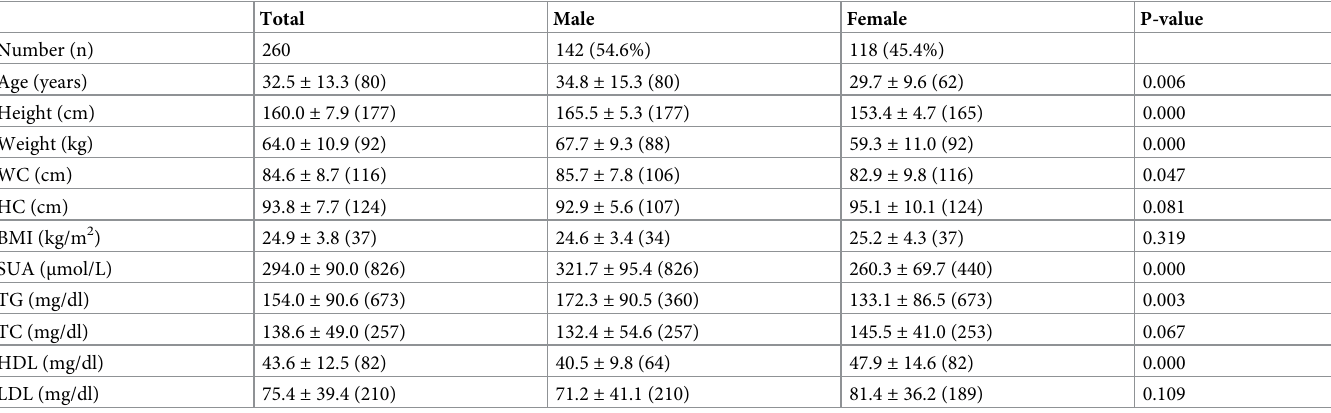
Table 1. Baseline characteristics and SUA level of the study